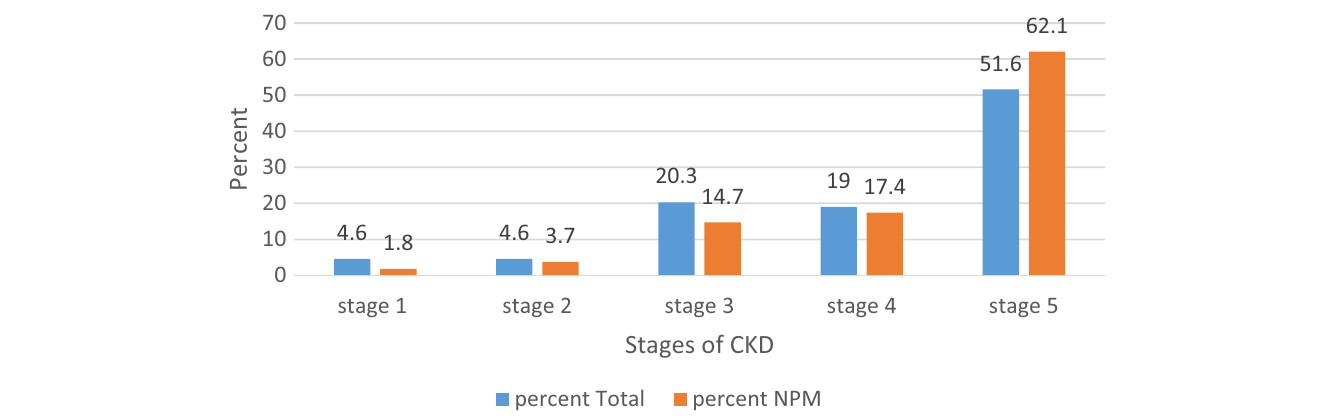
Figure 1. Distribution of Neuropsychiatric manifestations (NPM) according to the stages of CKD. CKD, chronic kidney disease.